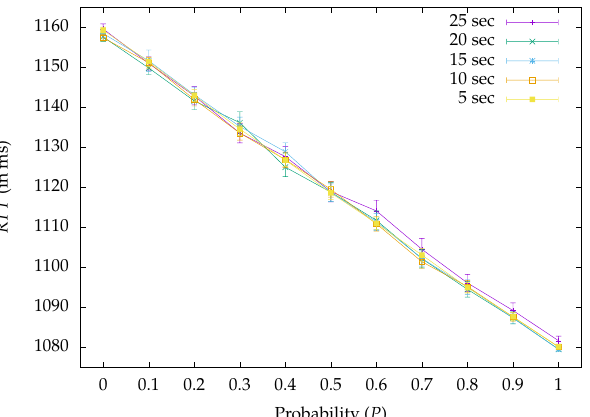
Figure 6. Experimental results of the system’s total mean RTT as a function of the probability P for different data packet generation intervals, i.e., for 25 s, 20 s, 15 s, 10 s, and 5 s. The error bars represent the upper and lower 95% confidence intervals.